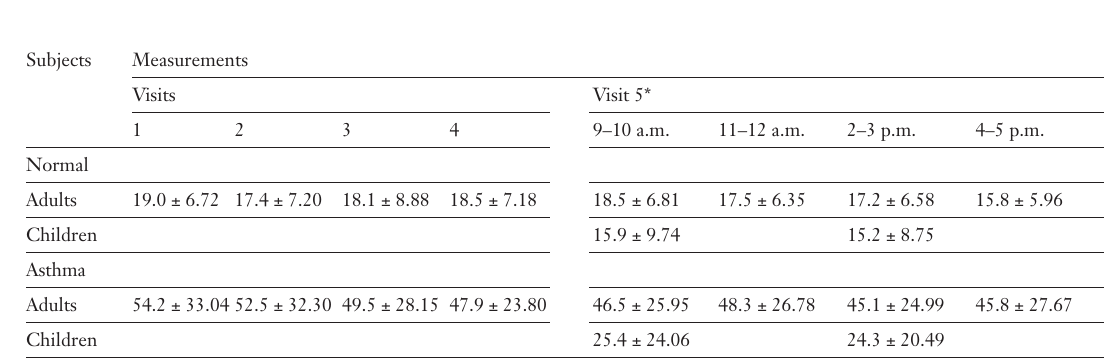
Reproducibility of FE NO